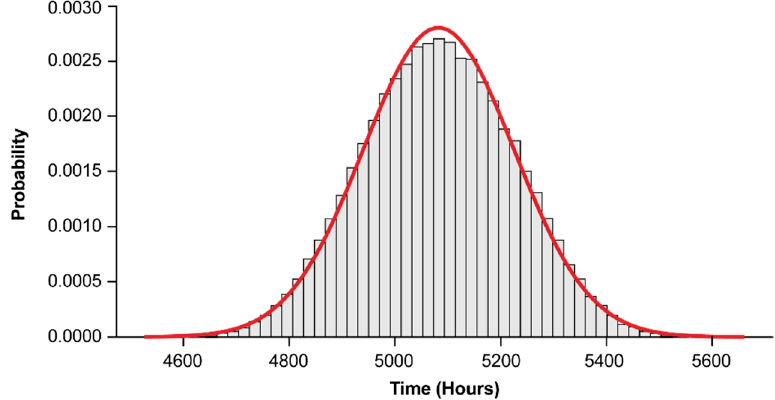
Figure 11. Predicted cumulative report preparation time as a distribution.